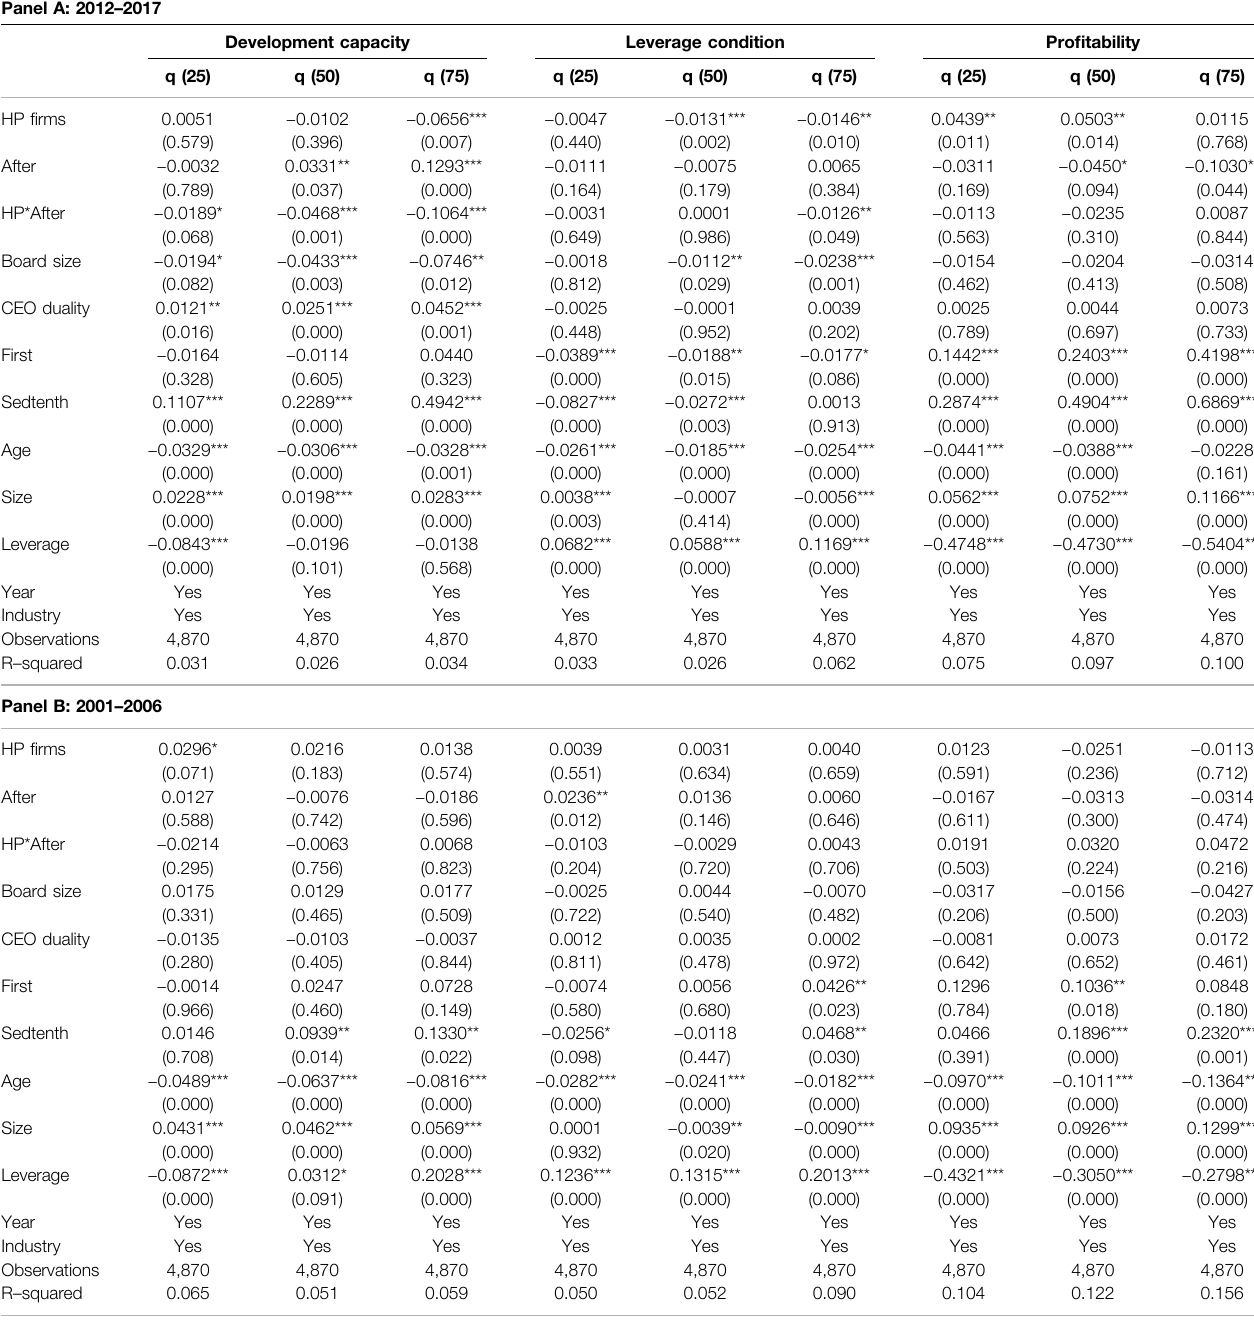
TABLE 4 | Quantile analyses. This table presents the results of quantile analyses. For the de fi nitions of variables refer to Appendix A . P -values are in